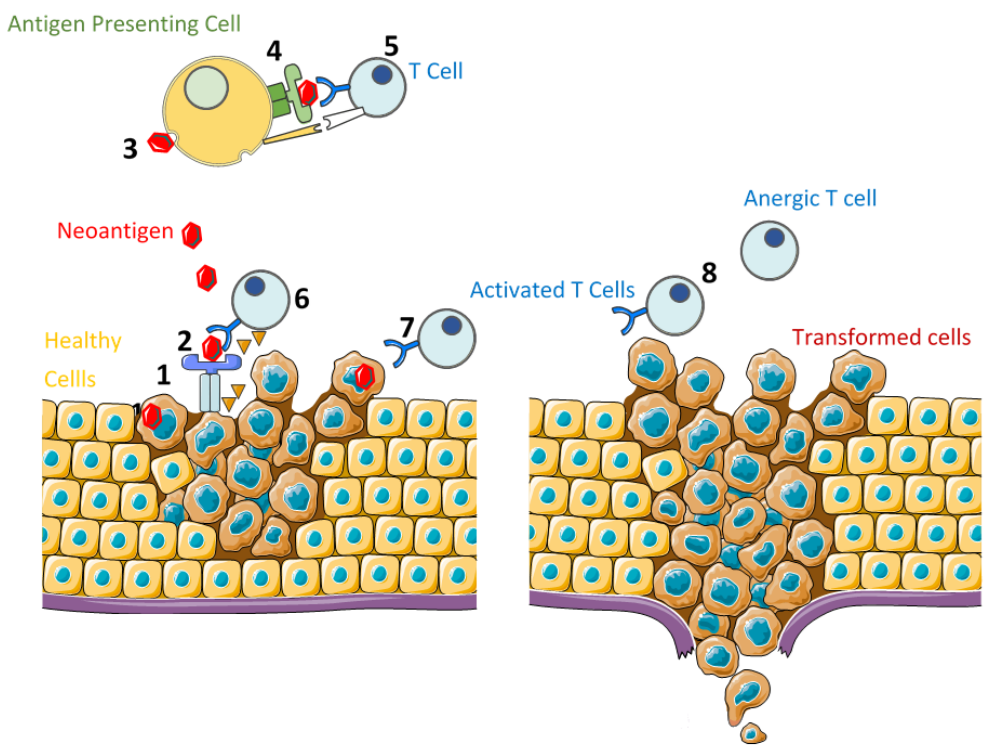
Figure 1. Cancer Immunoediting. ELIMINATION: (1) Neoantigen production by transformed cells.